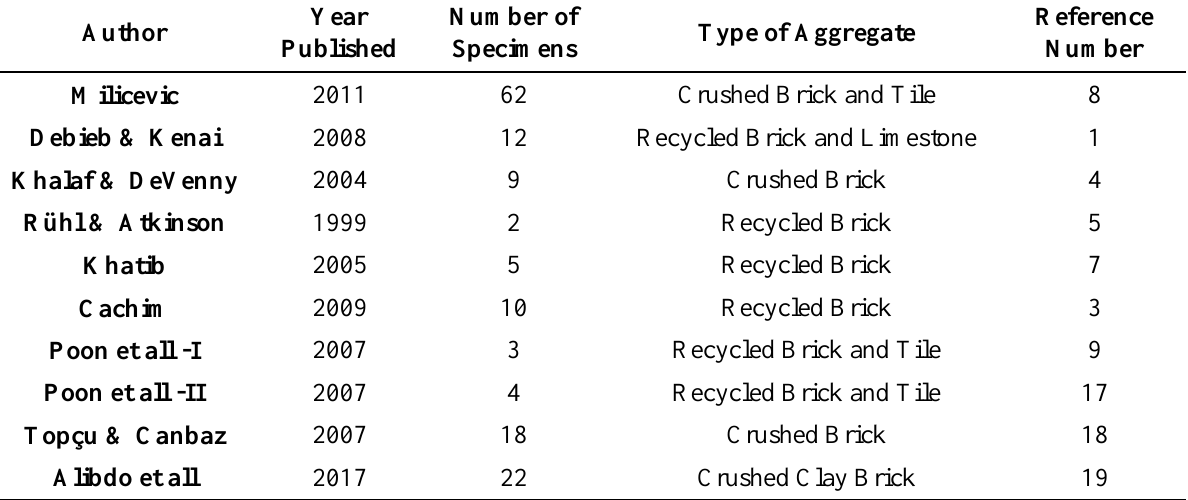
RBAC Experimental Database List Used in This